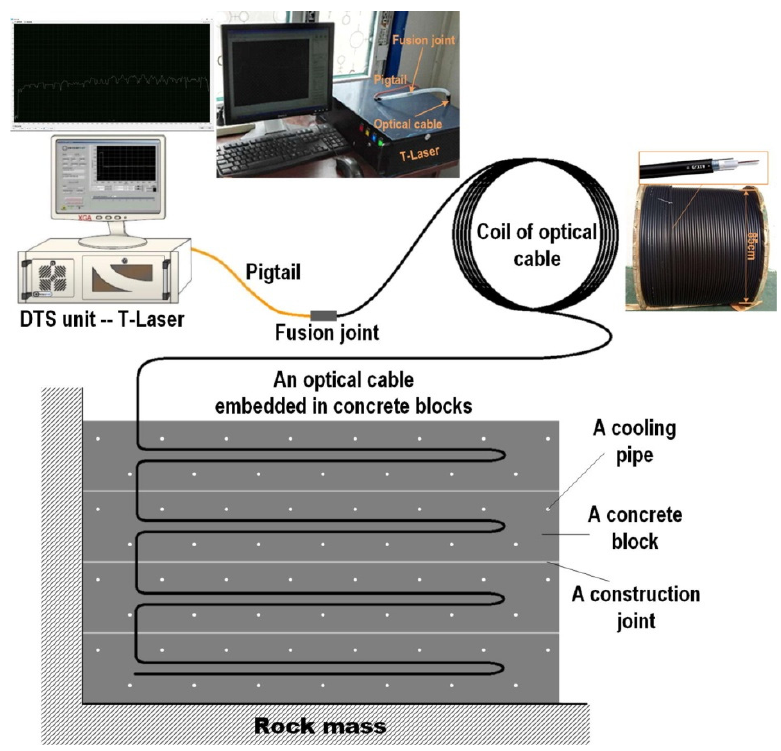
Figure 5. The diagram of the distributed temperature sensing (DTS) system [131] .